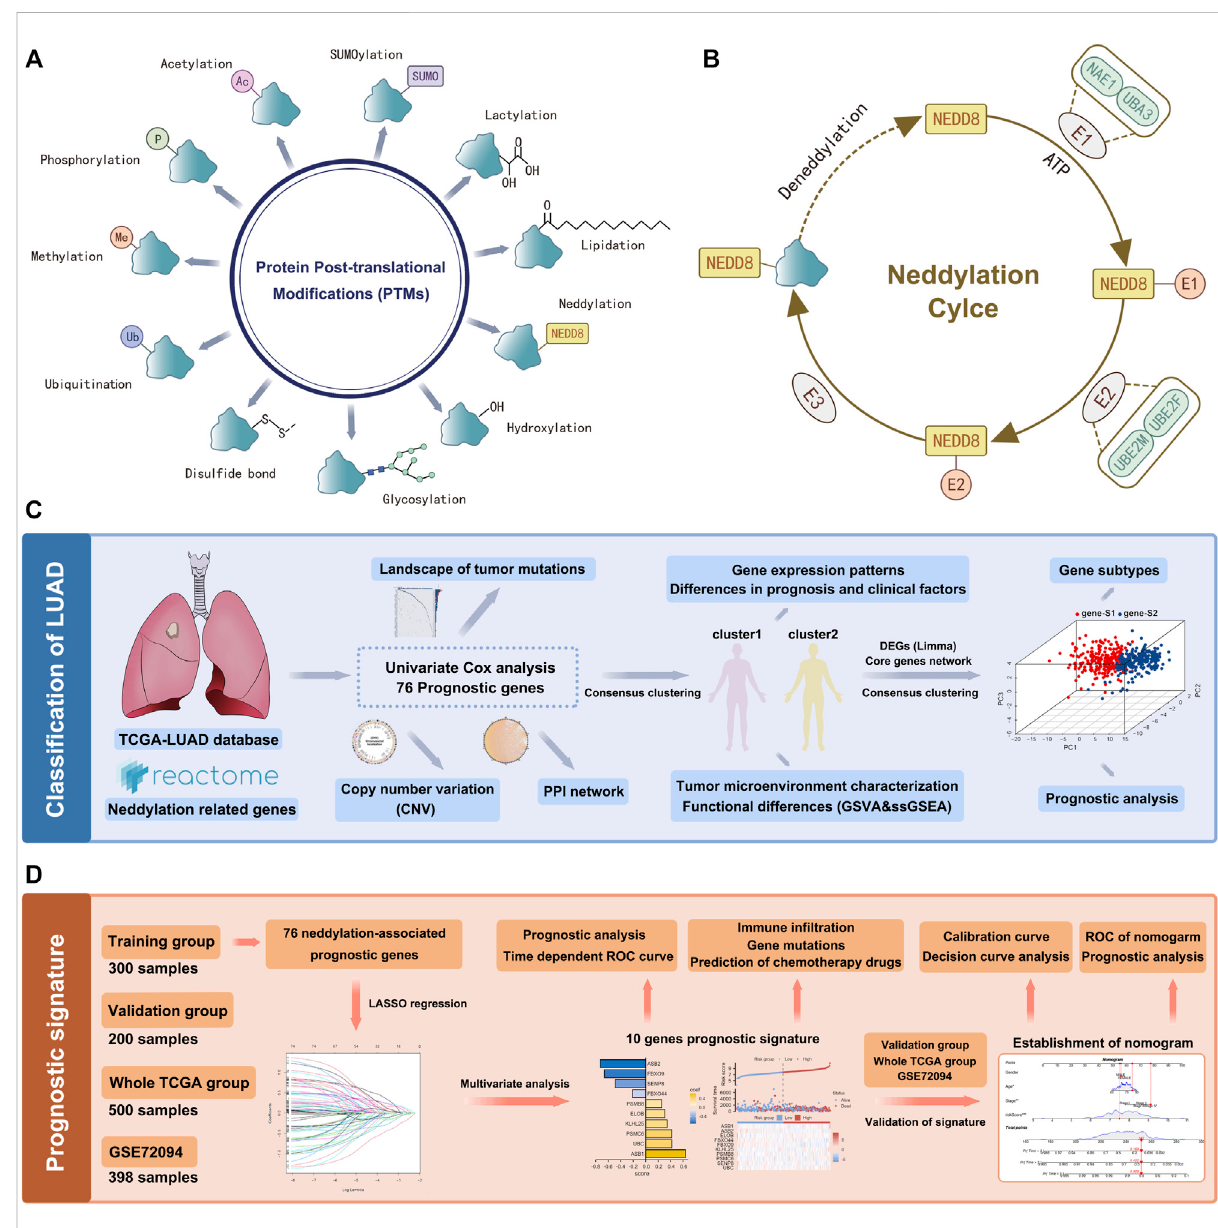
FIGURE 1 Flow chart of the data analysis. (A) PTMs of proteins. (B) Process of neddylation modi fi cation. (C) LUAD classi fi cation based on neddylation- related genes. (D) Prognosis signature based on neddylation-related genes.